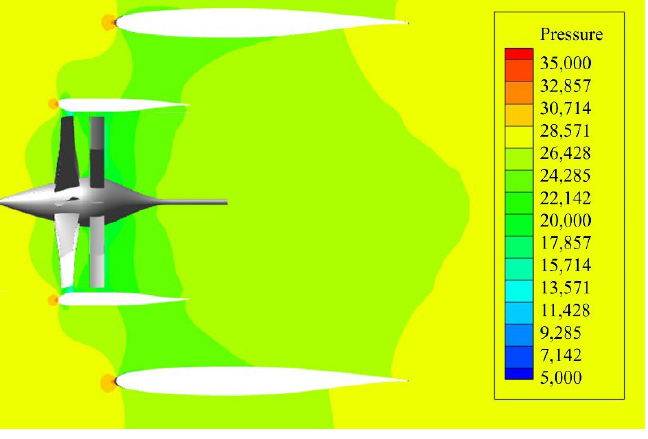
Figure 17. Pressure contours at position of a = 0.4 m, b = 0.2 m, c = 0.2 m.